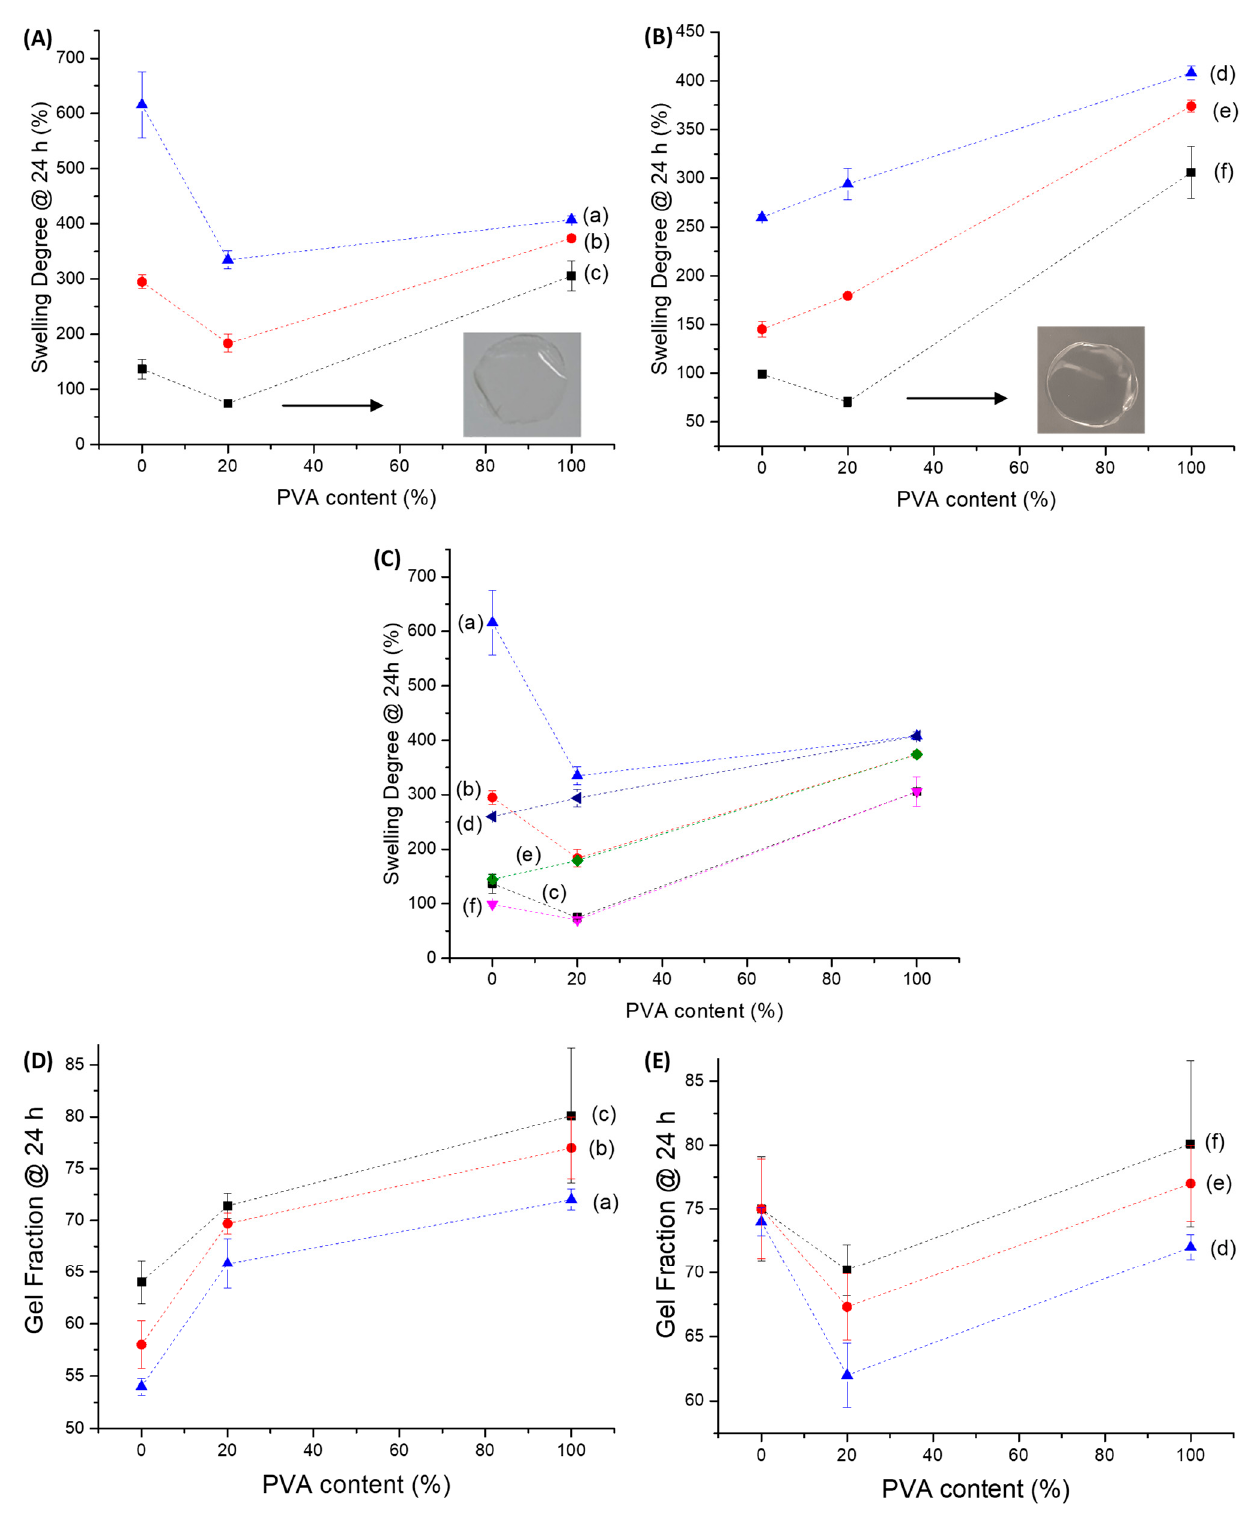
Figure 8. Swelling degree (( A ) CMC-250:PVA, ( B ) CMC-700:PVA, and ( C ) effect of CMC Mw. Inset: digital images of hybrids at CA25) and gel fraction (( D ) CMC-250:PVA and ( E ) CMC-700:PVA) properties of hybrids crosslinked with different amounts of CA: ( a ) CMC-250:PVA_CA15, ( b ) CMC- 250:PVA_CA20, ( c ) CMC-250:PVA_CA25, ( d ) CMC-700:PVA_CA15, ( e ) CMC-700:PVA_CA20, and ( f ) CMC-700:PVA_CA25.